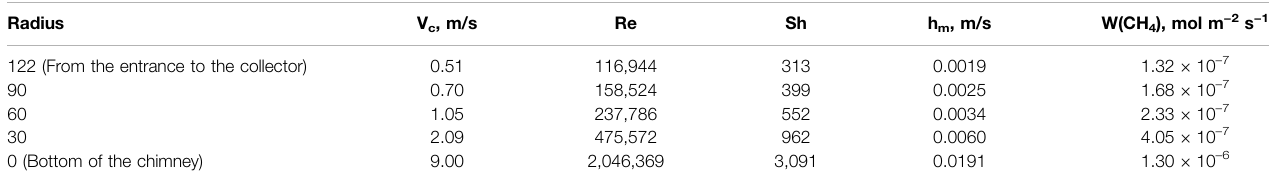
TABLE 4 | Key parameters at different positions under the collector for 50 kW SUT.